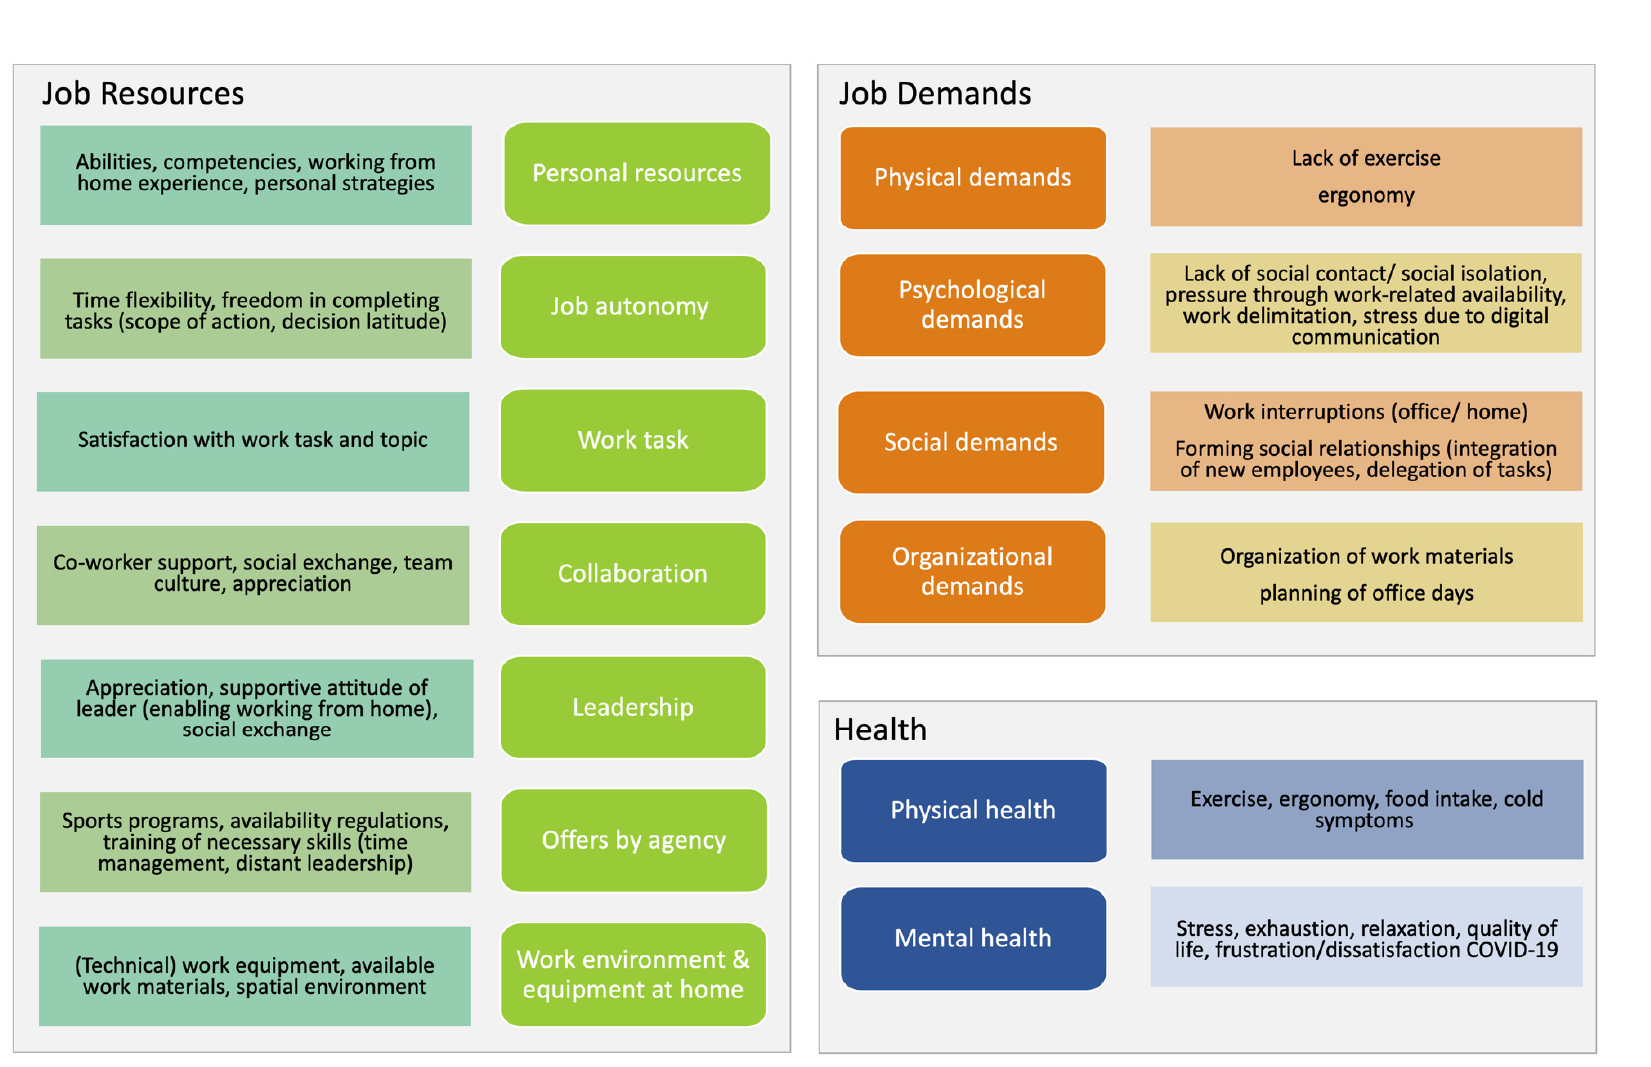
Figure 1. Main- and subcategories of the conducted interviews.